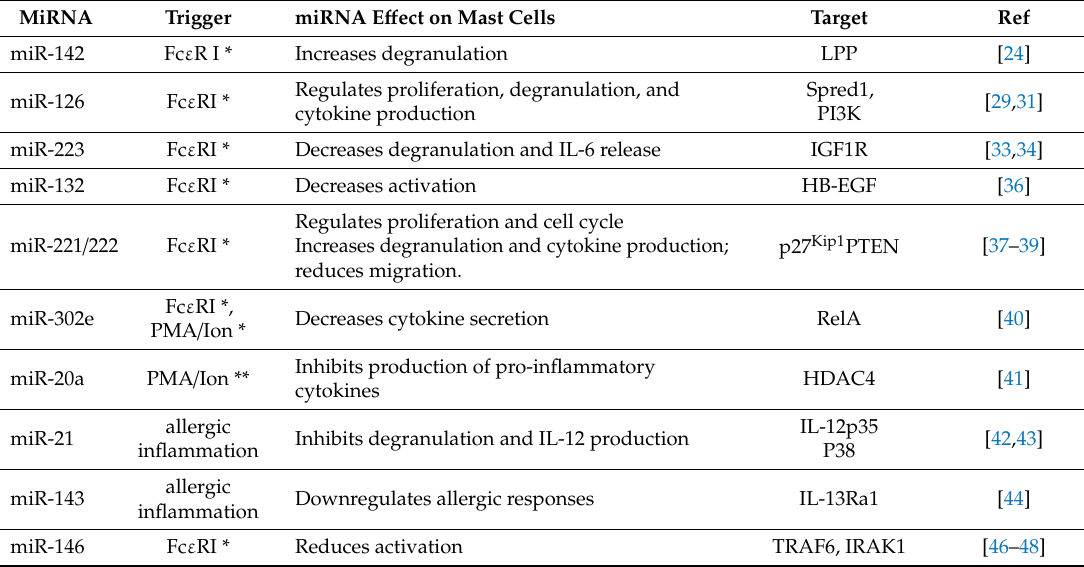
Figure 2. MiRNA’s e ff ect on mast cell activation. Red arrows indicate decreased mast cell activation by miRNAs. Blue arrows: increased activation of the mast cell. Table 1. miRNAs’ function in mast cell activation and proliferation.